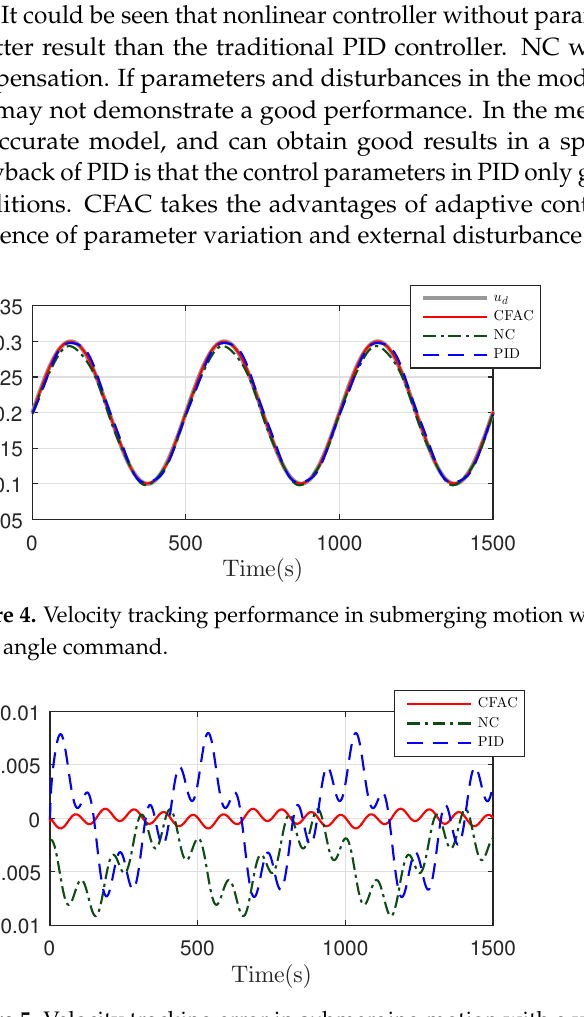
Figure 5. Velocity tracking error in submerging motion with a variable velocity and constant pitch angle